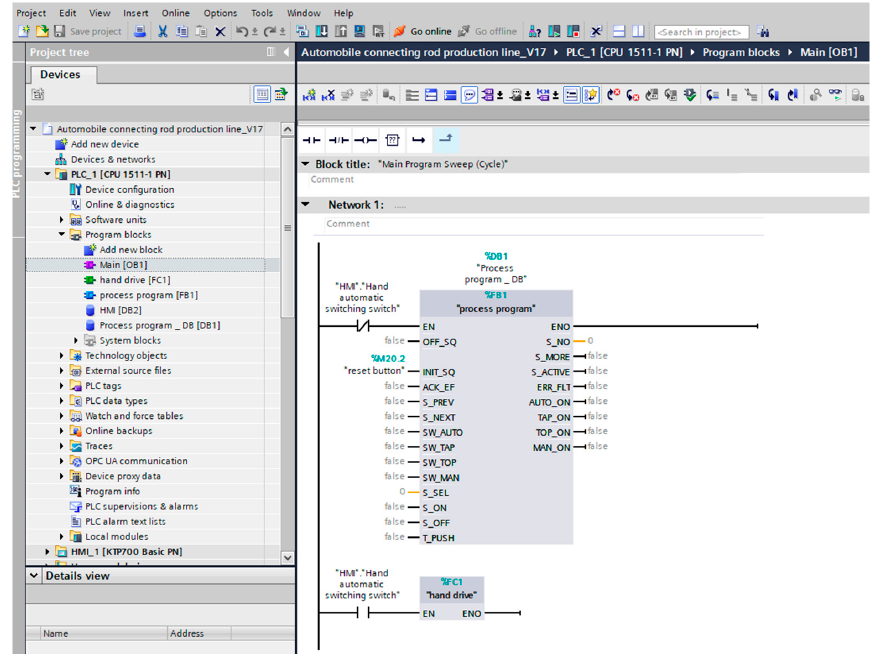
Figure 9. The simulation process of the model of the first part of the processing